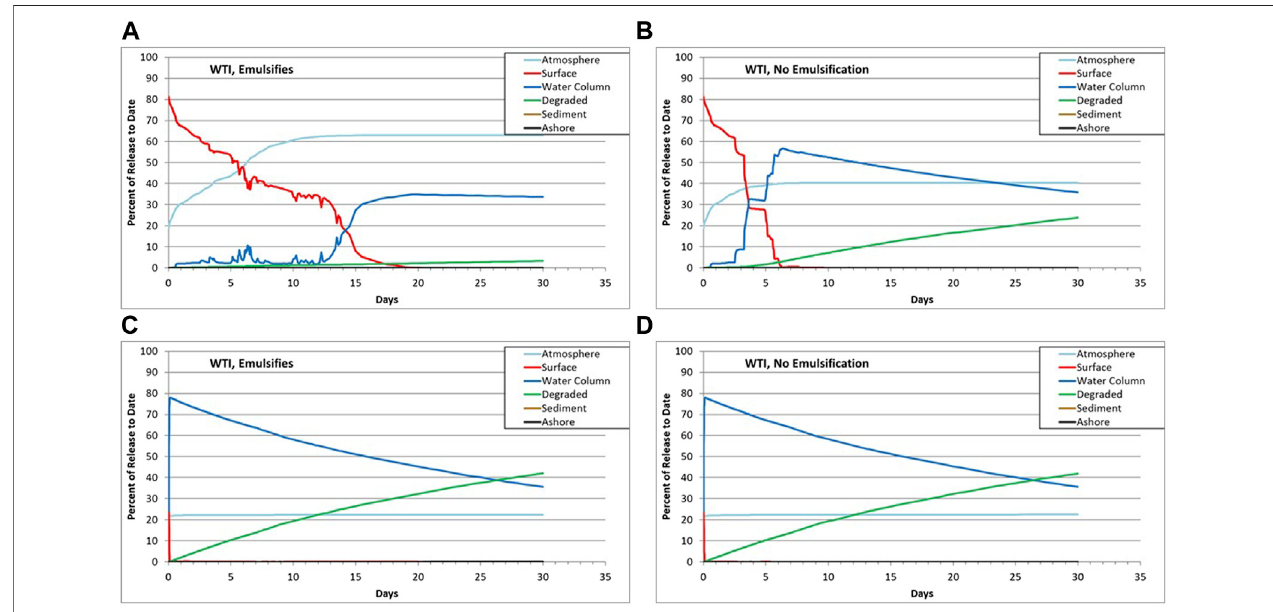
FIGURE6 | Massbalance(as percent ofthe spilled mass) for asurface release of200 MT ofWTI for the runs that ledto the 95th percentile for surface oil exposure [ (A,B) ; 15 June 2008] and for water column exposure [ (C,D) ; 15 December 2008], including emulsi fi cation (A,C) and not including emulsi fi cation (B,D) .